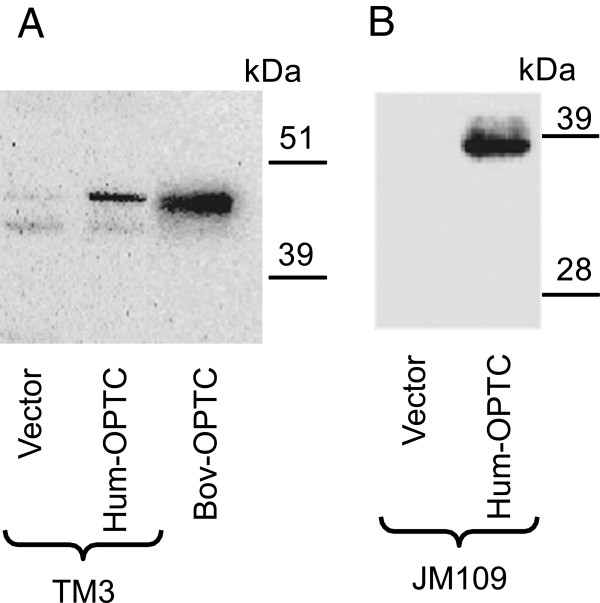
Western blot analyses to validate the specificity of the own-produced anti-OPTC antibody. The precursor OPTC gene was cloned into pcDNA3.1+ vector and transfected into A) mouse TM3 cell line and B) E. coli JM109. Lane 1: Lysate of cells transfected with the vector alone (negative control). Lane 2: Lysate of cells transfected with the OPTC construct. Lane 3: bovine OPTC produced in HEK-293 cells. Our C-terminal pAb detected a 48 kDa human OPTC expressed in TM3 cells, a 37–38 kDa OPTC produced in bacteria JM109 and a 45–50 kDa recombinant bovine OPTC.